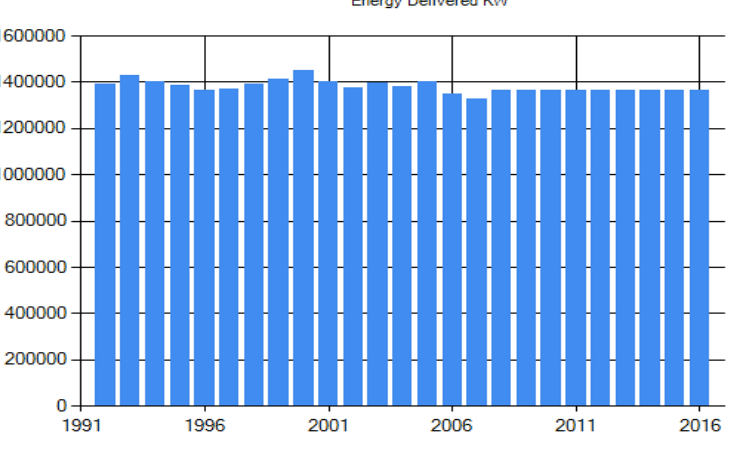
Figure 5. Yearly Energy